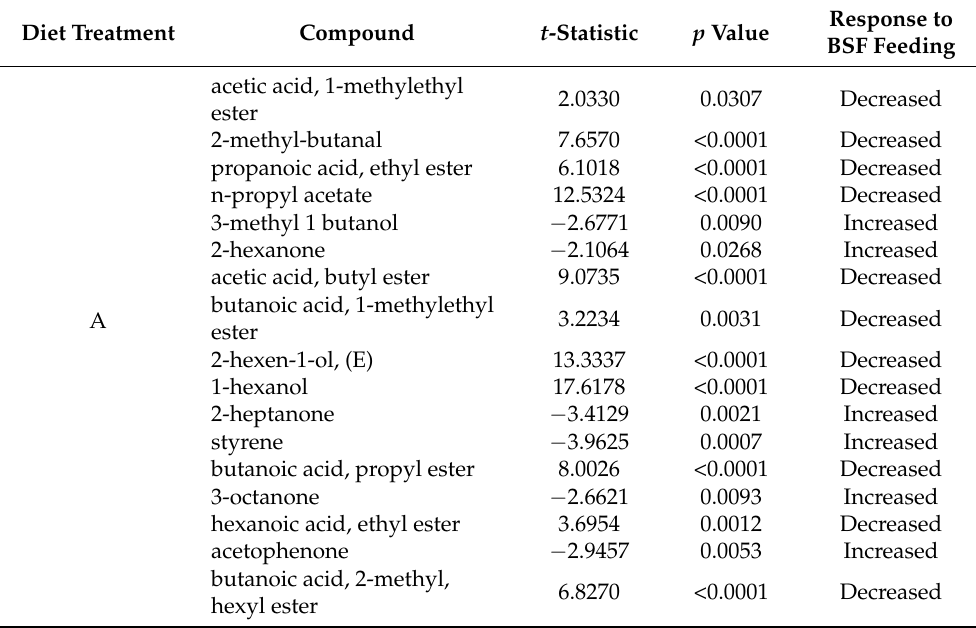
Table 4. Differential production of 25 VOCs of interest, in response to larval feeding. A, apple; B, banana; SG, spent grain; AB, apple and banana; ASG, apple and spent grain; BSG, banana and spent